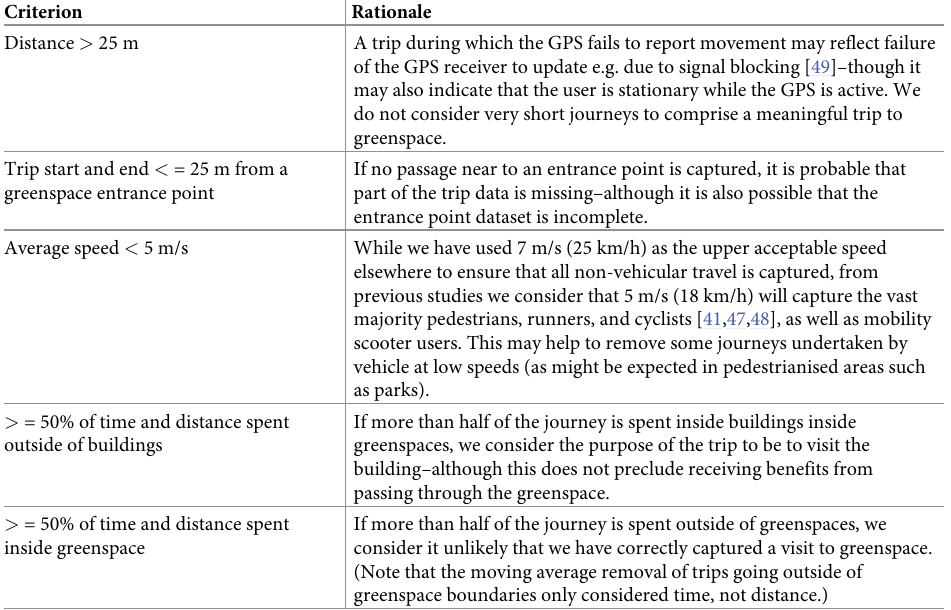
Table 2. Criteria for determining level of certainty in whether trip data is an accurate representation of a non- vehicular trip to a